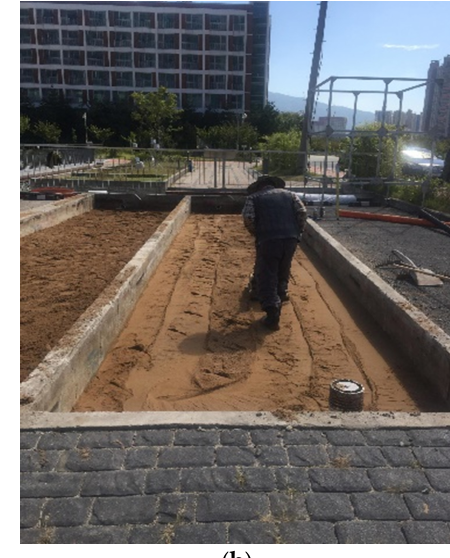
Figure 5. Laying the geotextile layer and compacting the sand layer ( a ) laying the geotextile layer; ( b ) vibratory compaction.